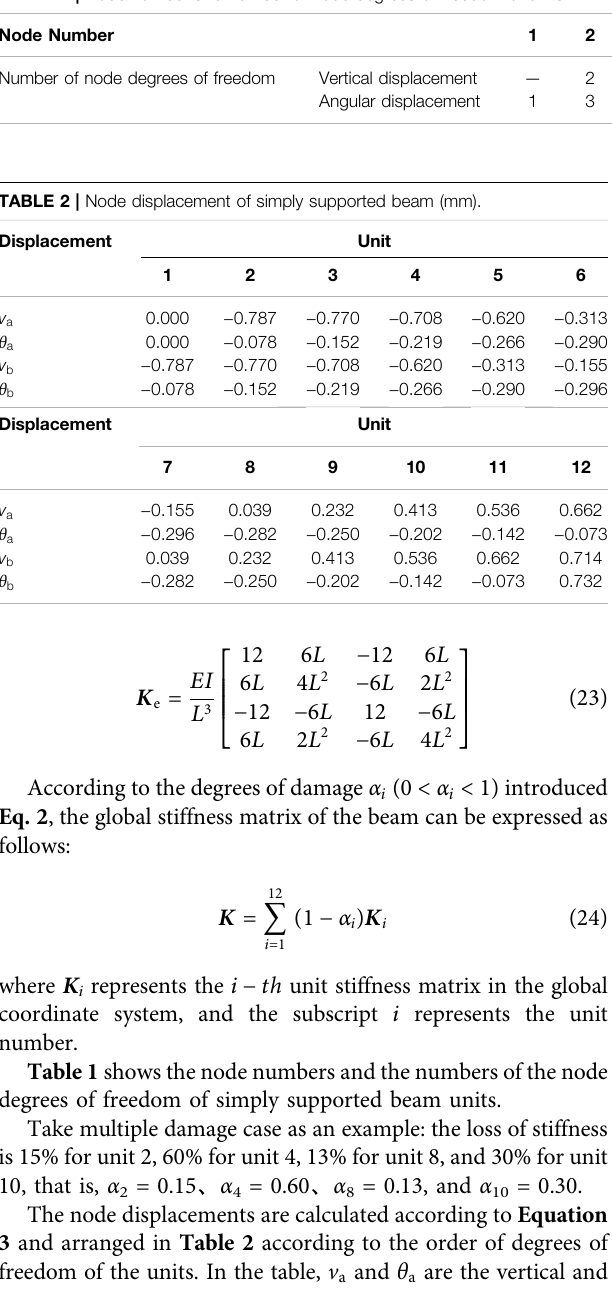
TABLE 1 | Node number and number of node degrees of freedom of units.